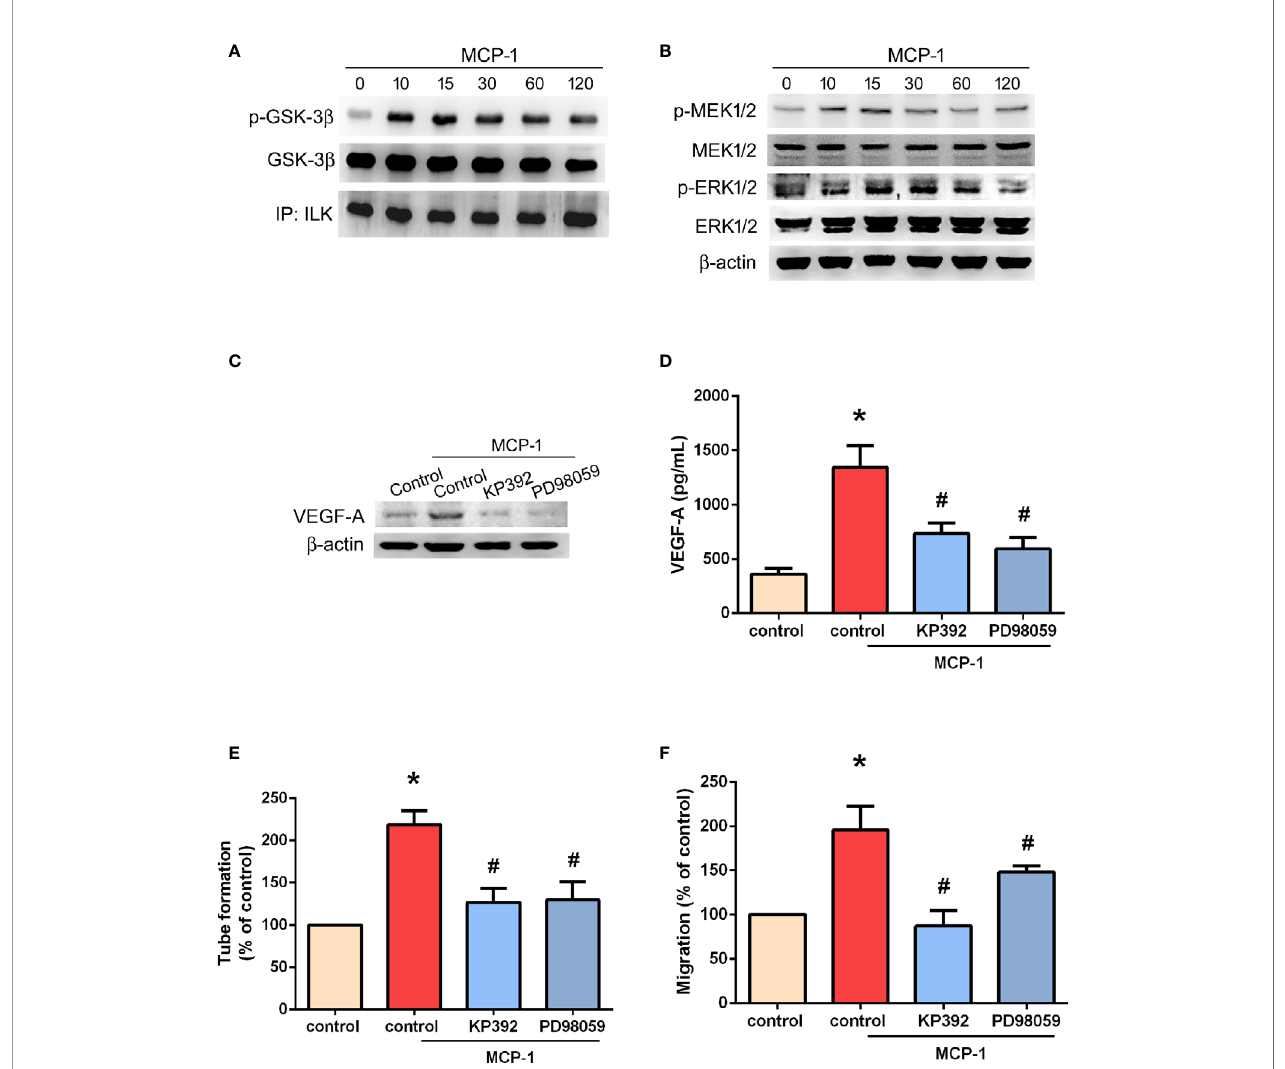
FIGURE 4 | ILK/MEK1/2 signaling is involved in MCP-1 – induced VEGF-A expression and angiogenesis. Cells were incubated with MCP-1 (50 ng/ml) for the indicated time intervals; (A) Cell lysates were immunoprecipitated (IP) with ILK antibodies prior to Western blotting using p-GSK-3 b , GSK-3 b , and ILK antibodies. (B) MEK1/2, and ERK1/2 activation was examined by the Western blot assay. (C, D) Cells were treated with an ILK inhibitor (KP392; 10 m M) or MEK1/2 inhibitor (PD98059; 10 m M) for 30 min, then stimulated with MCP-1 (50 ng/ml) for 24 h. VEGF-A expression was measured by Western blot and ELISA assays. (E, F) Cells were treated with a KP392 (10 m M) or PD98059 (10 m M) for 30 min, then stimulated with MCP-1 (50 ng/ml) for 24 h. CM was applied to EPCs for 24 h, then capillary-like structure formation was examined by the tube formation assay (E) and cell migration by the Transwell assay (F) . * p < 0.05 compared with controls; # p < 0.05 compared with MCP-1 – treated controls. Each experimental procedure was independently repeated three times, with similar